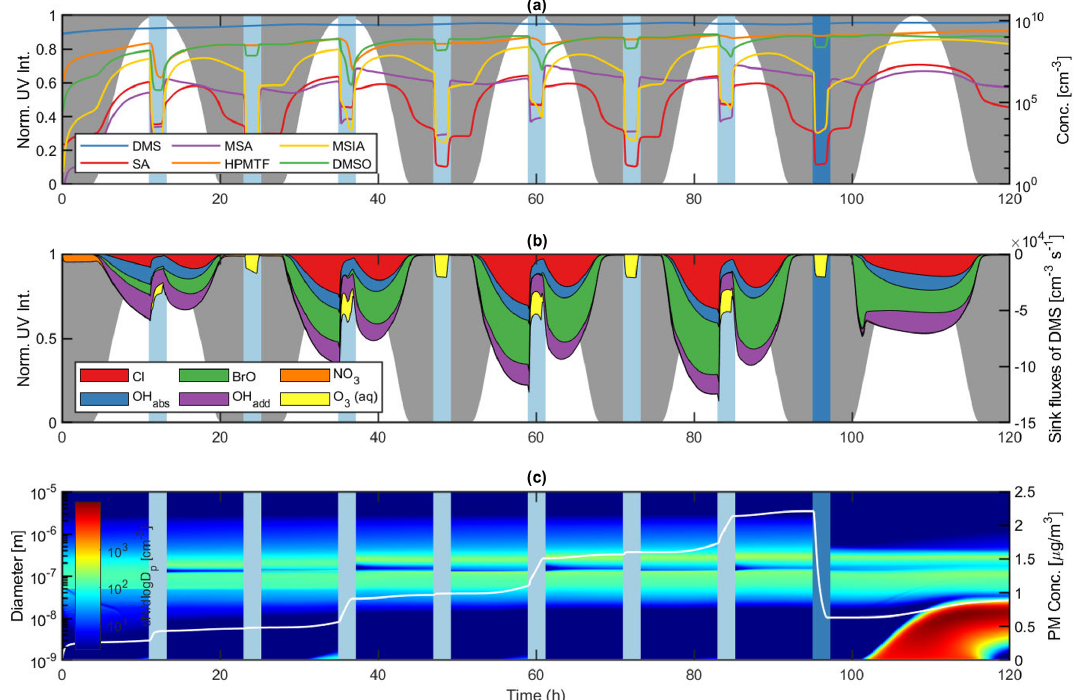
Figure 5. Modelled DMS oxidation and subsequent PM production in pristine marine environment conditions. Panel (a) illustrates the evolution of DMS, SA, MSA, HPMTF, MSIA and DMSO gas-phase concentrations, (b) the sink fluxes of DMS due to Cl, OH, BrO, NO 3 and O 3 and (c) the number size distribution and secondary aerosol PM production. Light blue areas denote in-cloud period, in which rain events are represented as dark blue. Night-time and daytime periods are represented by the normalized UV intensity and marked by grey and white areas,